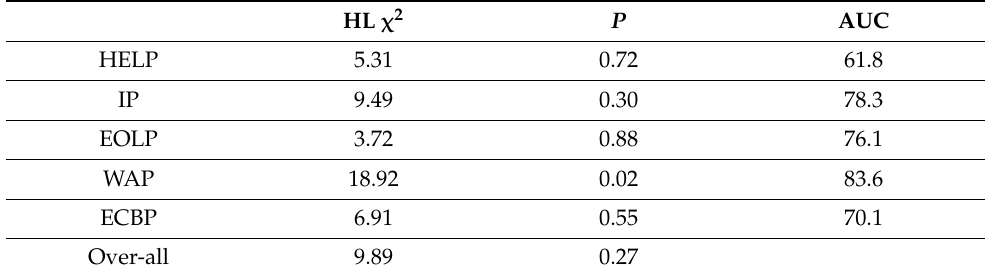
Table 2. Model fit